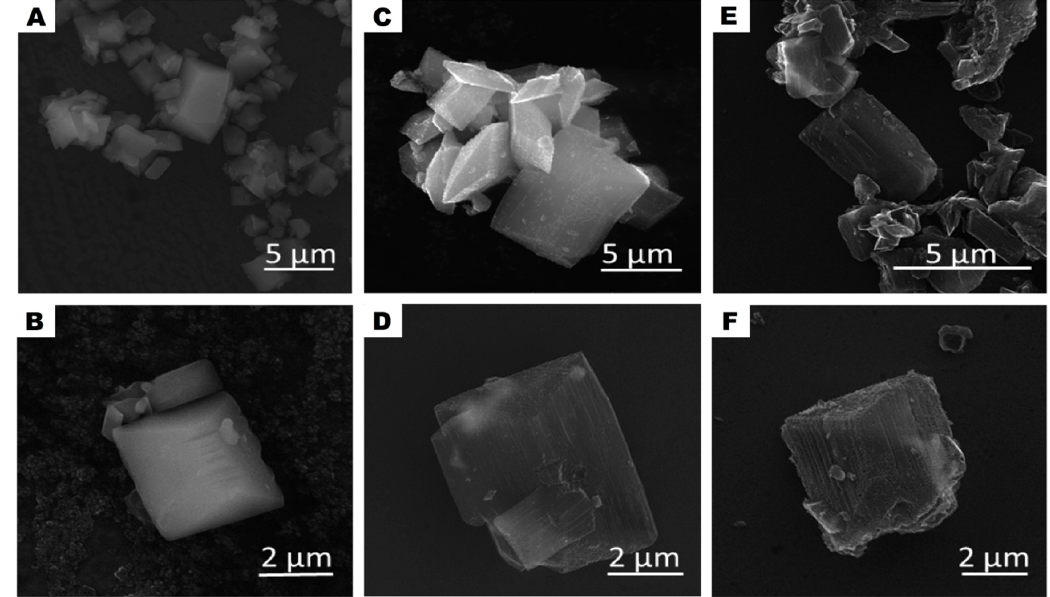
Figure 2. SEM images of MOF-La ( A , B ) and MOF-derived carbon structures CMOF-La ( C , D ) and CMOF ( E , F ). Nanomaterials 2020 , 10 , x